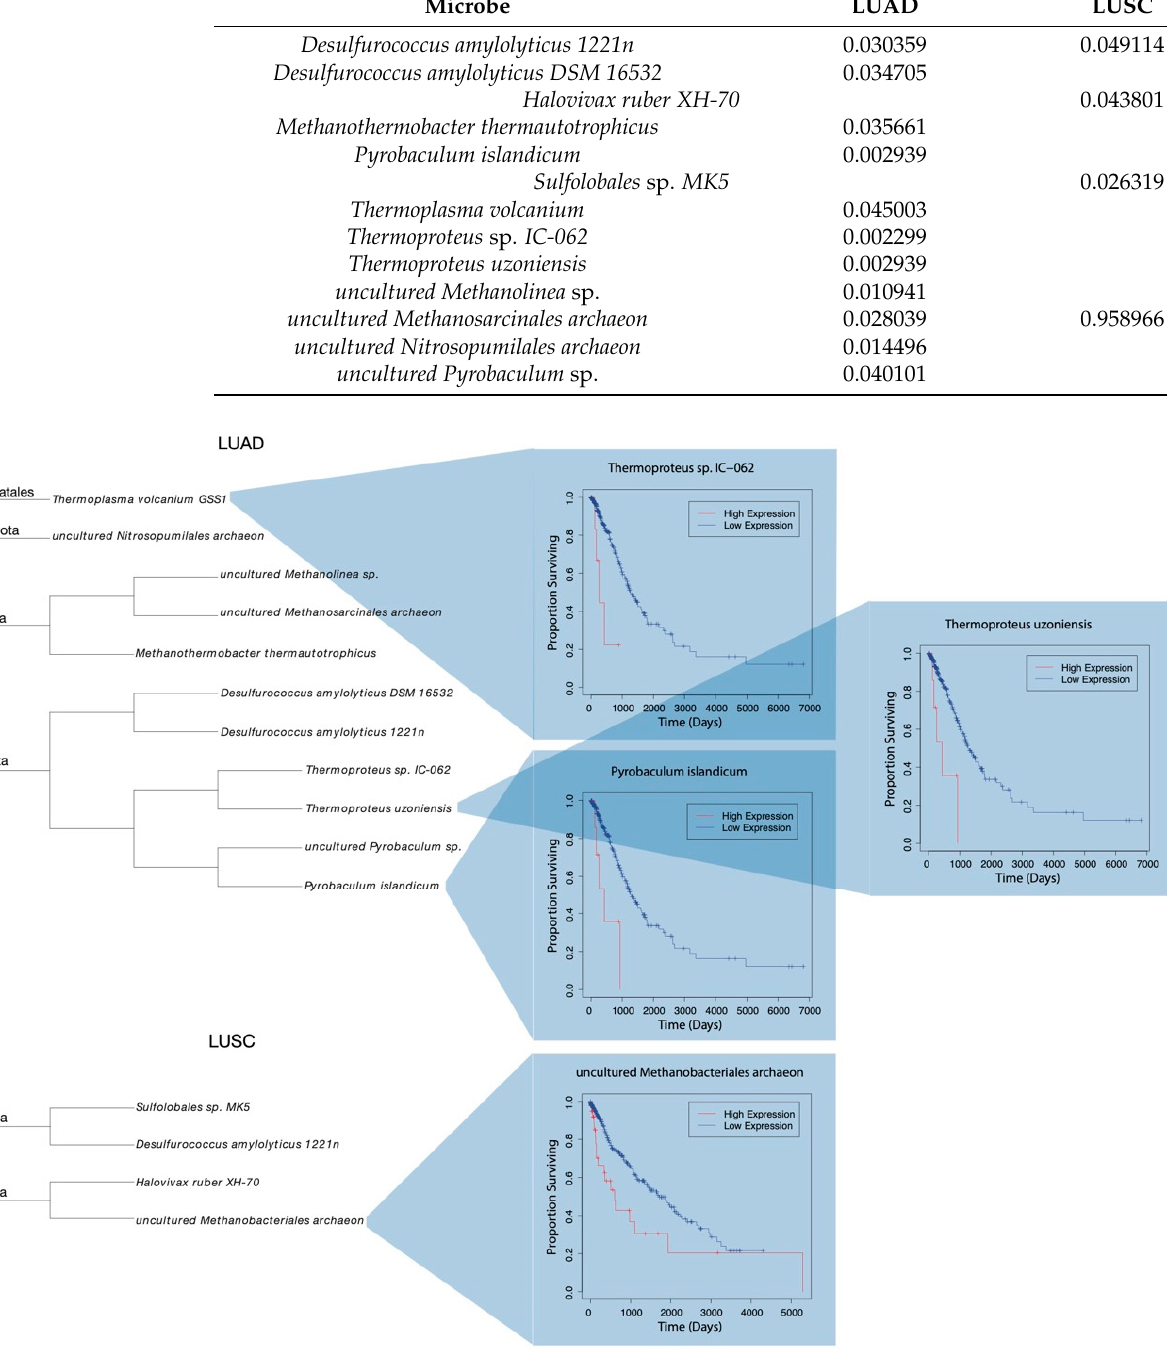
Table 3. List of survival-significant microbes across LUAD and LUSC samples. Corresponding P- Value denoting significance of relationship.